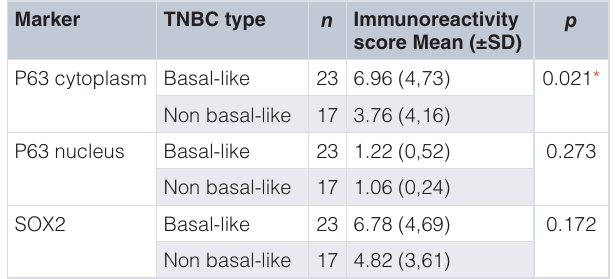
Table 4. Immunoexpression of P63 and SOX2 in Basal-like type TNBC and Non basal-like type TNBC.